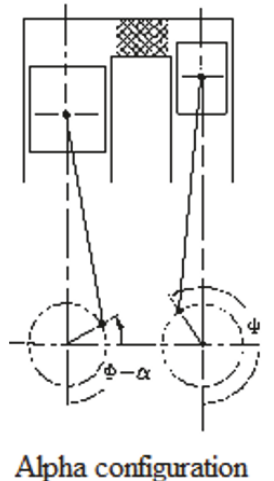
Figure 4: Alpha Stirling engine configuration.